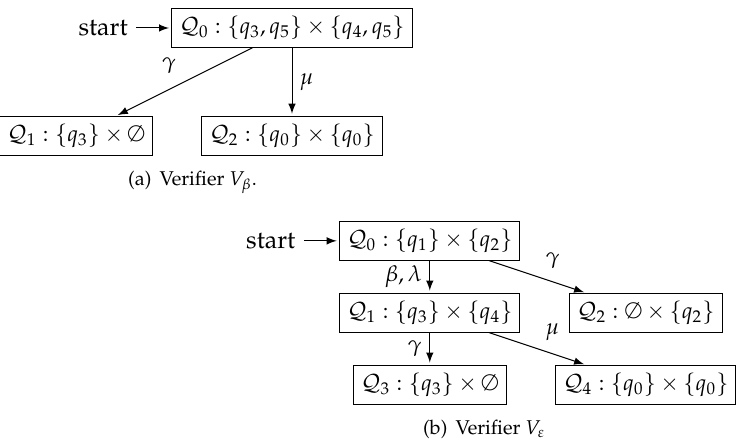
Figure 2. Verifiers V β and V ε for G ( q 1 ) and G ( q 2 )